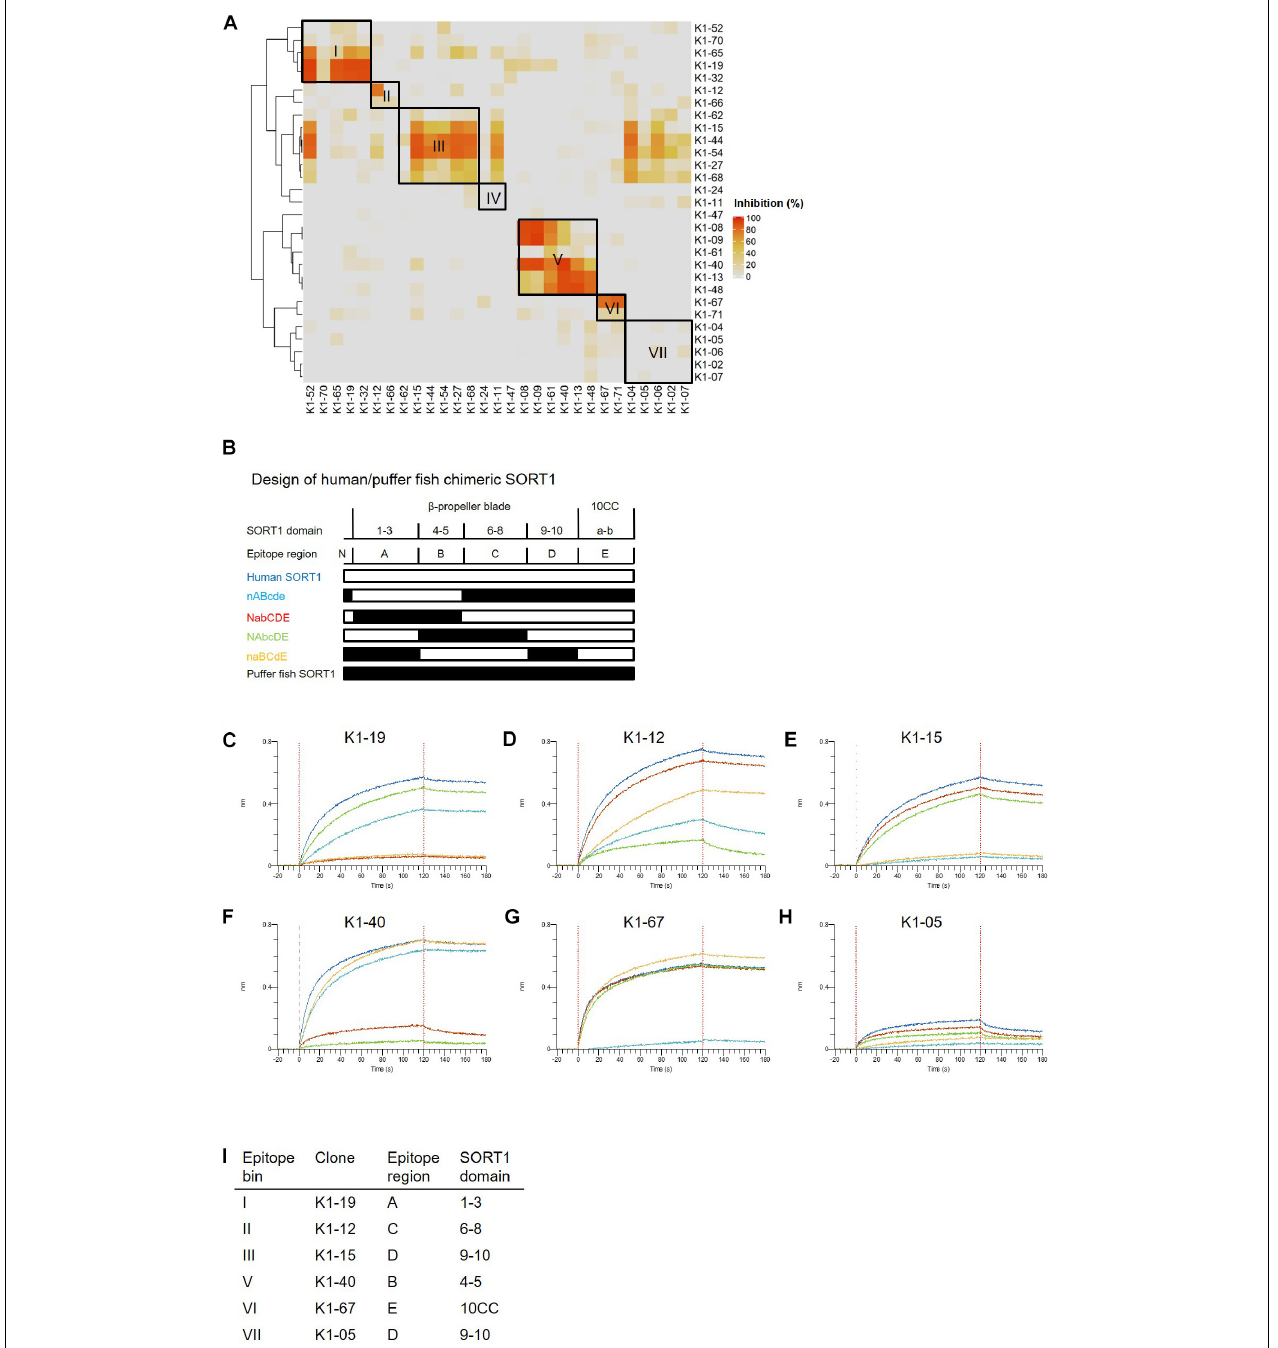
FIGURE 1 | Binding profiles of anti-SORT1 mAbs. (A) Epitope binning of anti-SORT1 mAbs. The competitive binding was measured in a sandwich ELISA with 29 anti-SORT1 mAbs. Each column and row in the matrix represent an unlabeled and biotinylated anti-SORT1 mAb. The competitive binding of the 29 anti-SORT1 mAbs is shown as a heat map analyzed by Ward’s hierarchical clustering. The color scale from 0 to 100 shows the competitive binding of the 2 mAbs. (B) Design of chimeric proteins; nABcde (human SORT1 A, B and puffer fish SORT1 N-terminal C, D, E regions), NabCDE (human SORT1 N-terminal, C, D, E and puffer fish SORT1 A, B regions), NAbcDE (human SORT1 N-terminal, A, D, E and puffer fish SORT1 B, C regions), and naBCdE (human SORT1 B, C, E and puffer fish SORT1 N-terminal, A, D regions). The white bar indicates the SORT1 domain derived from human and the black bar indicates the SORT1 domain derived from puffer fish. (C–H) Epitope mapping of anti-SORT1 mAbs. Epitope mapping was analyzed by the binding pattern of anti-SORT1 mAb to human/puffer fish chimeric SORT1 proteins in BLI. The BLI analysis was performed with anti-SORT1 mAb K1-19 (C) , K1-12 (D) , K1-15 (E) , K1-40 (F) , K1-67 (G) , and K1-05 (H) as ligands and chimeric SORT1 protein as an analyte. The vertical axis indicates the BLI signal response (nm). The horizontal axis indicates the time after analyte loading. (I) Epitope mapping results of anti-SORT1 mAbs tested are shown in the table.